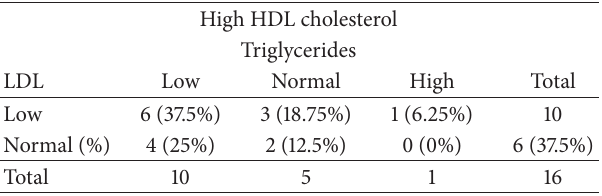
Table 5: Distribution of dyslipidemia in patients with a high HDL